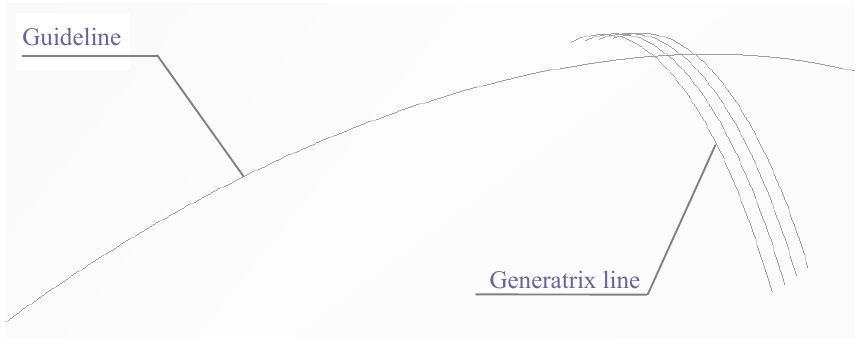
Figure 3: Grid shell geometry (© Werner Sobek